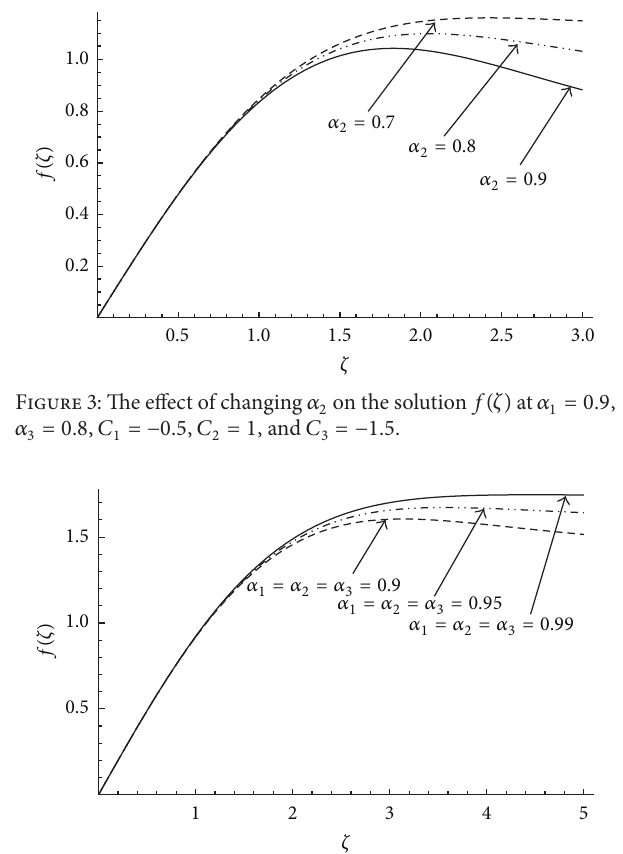
Figure 4: The solution 𝑓(𝜁) in the case ∑ 3 𝑖=1 𝐶 𝑖 = −1/2 at different values of 𝛼.